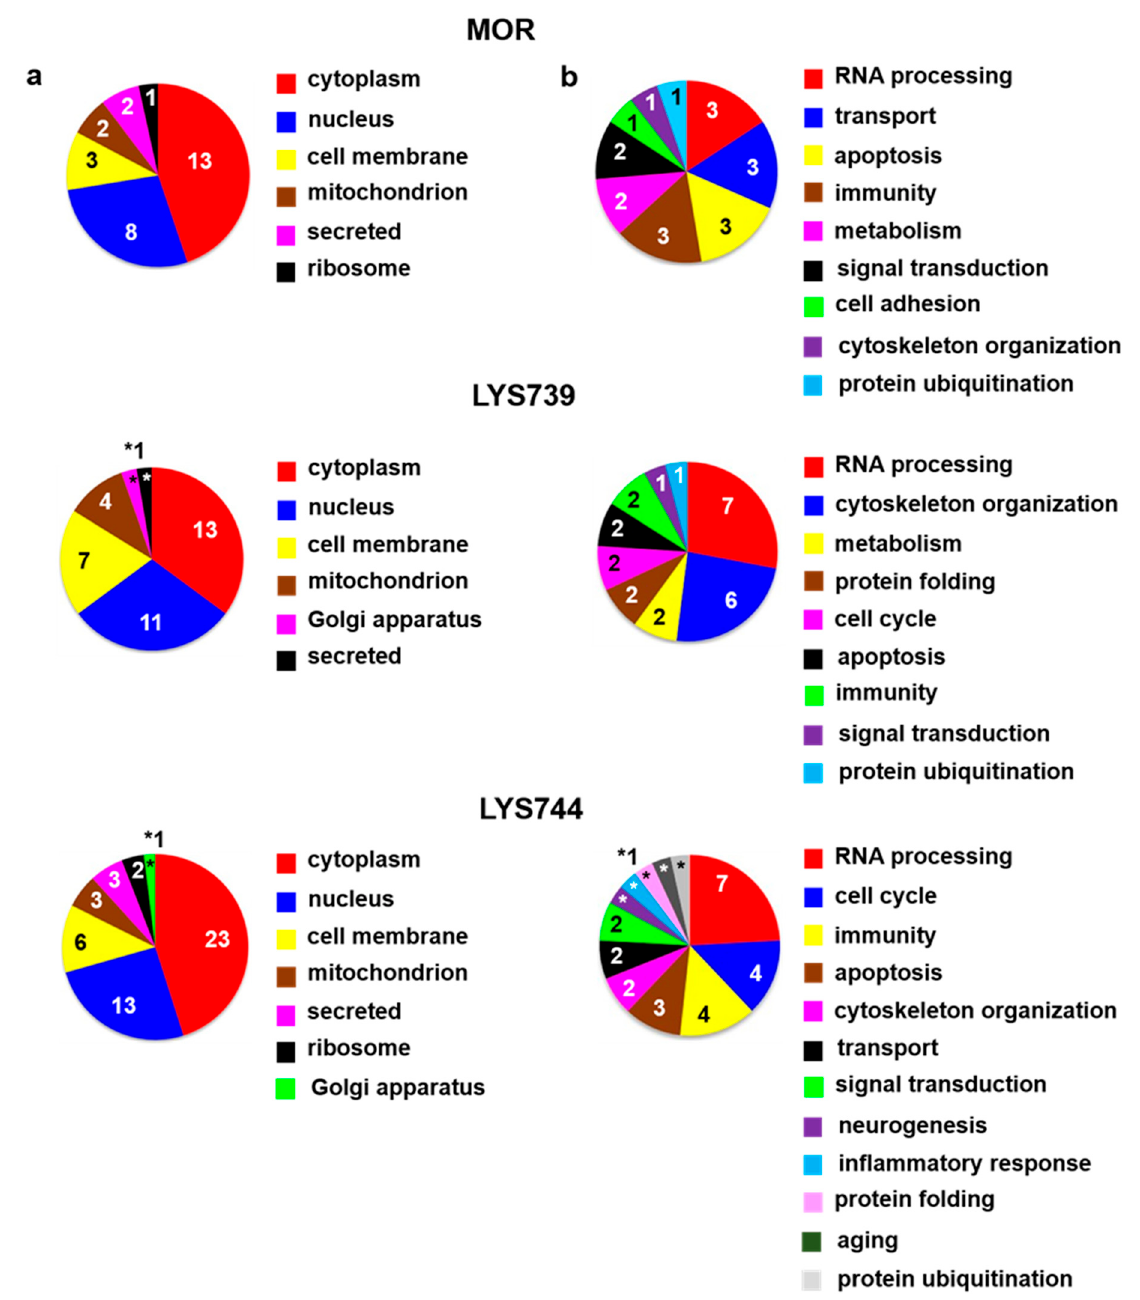
Figure 4. Subcellular localization ( a ) and function ( b ) of significantly altered proteins (at least 2-fold) identified in rat brain cortex after 7-day treatment with 3 mg/kg of morphine ( MOR , upper panels), LYS739 ( middle panels), and LYS744 ( lower panels); according to the current annotations in the Uniprot database (https://www.uniprot.org, accessed on 28 January 2022). The numbers represent proteins found within each subcellular localization and functional category, *1.